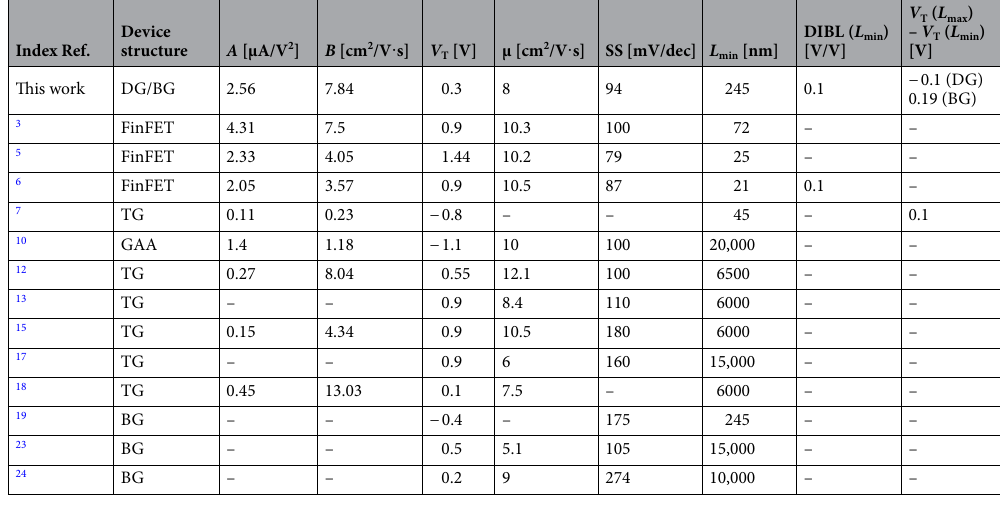
Table 1. Summary of the performance indices compared with previous studies.